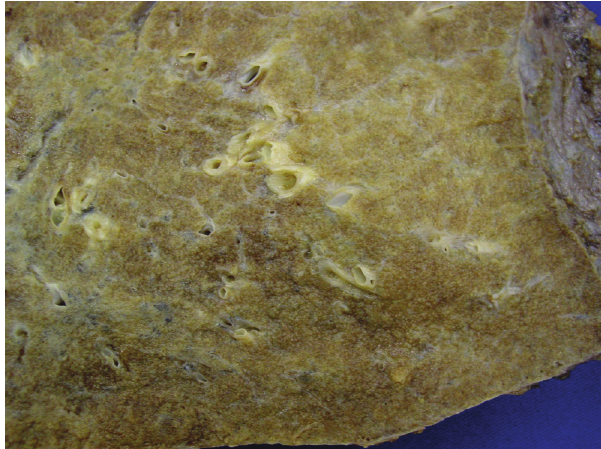
Figure 2 - Macroscopic view of the explanted lung showing a more consis- tent pulmonary parenchyma with reduced aeration, making the tissue more difficult to be sectioned. The surface of the piece exhibits a granular aspect. A “sandy” material is obtained by its